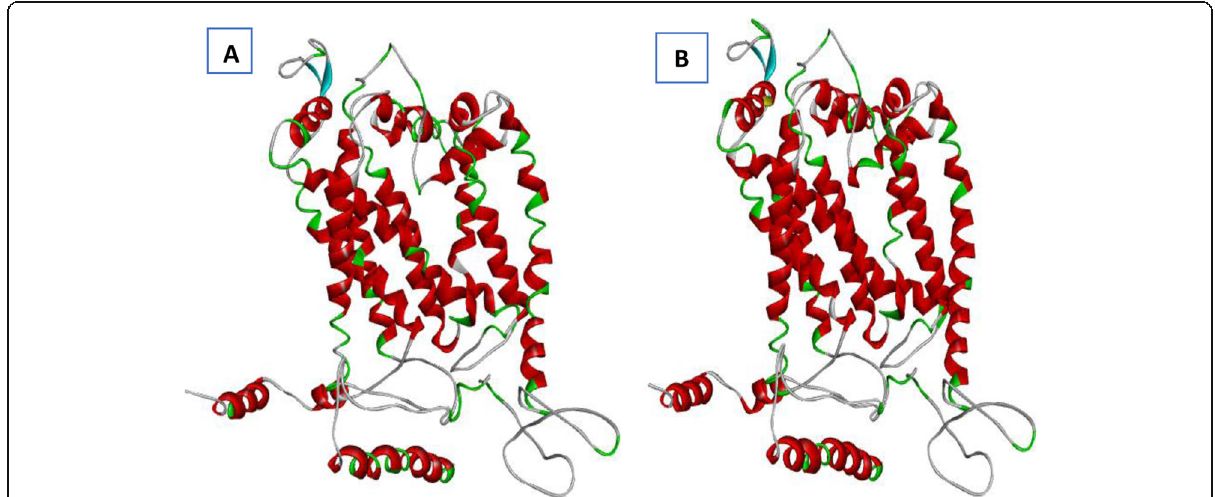
Fig. 3 Three-dimensional (3D) structures of QcrB protein. a 3D structure of QcrB protein of M. smegmatis (PDB: 6HWH). b Predicted 3D structure of M. tuberculosis of QcrB